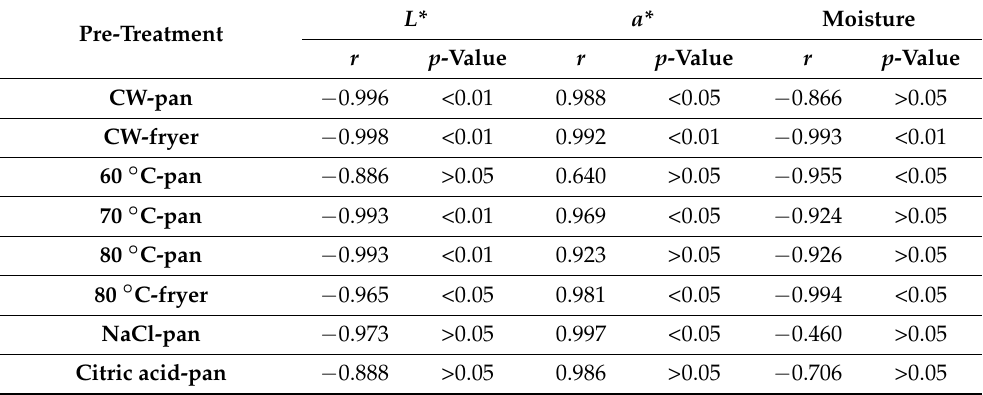
Table 6. Pearson correlation between acrylamide content and color parameters ( L*, a* ) and moisture content of French fries. L* a* Moisture Pre-Treatment r p -Value r p -Value r p